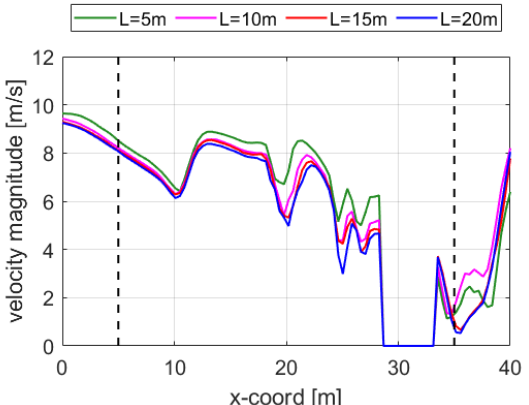
Figure 4. Velocity profiles along line 2 for different L values. The portion of the velocity profile between the black dashed lines is inside the platform.